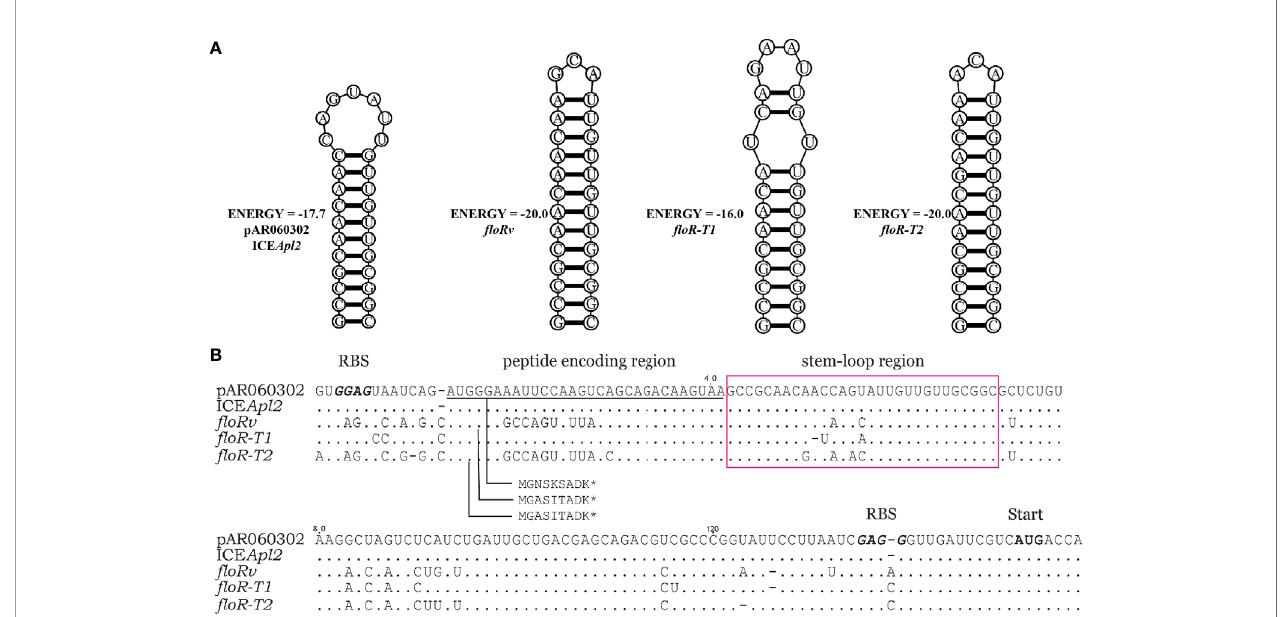
FIGURE 3 | Comparison of sequences upstream of the fl oR variants. (A) The stable mRNA secondary structure of the fl oR variants formed by inverted repeat sequences boxed in (B) . (B) The attenuator of the fl oR variants consists of a peptide-encoding region (underlined) and stem-loop region (boxed). The start codons and ribosome binding sites (RBS) of the short peptide and fl oR are labeled and displayed in bold type